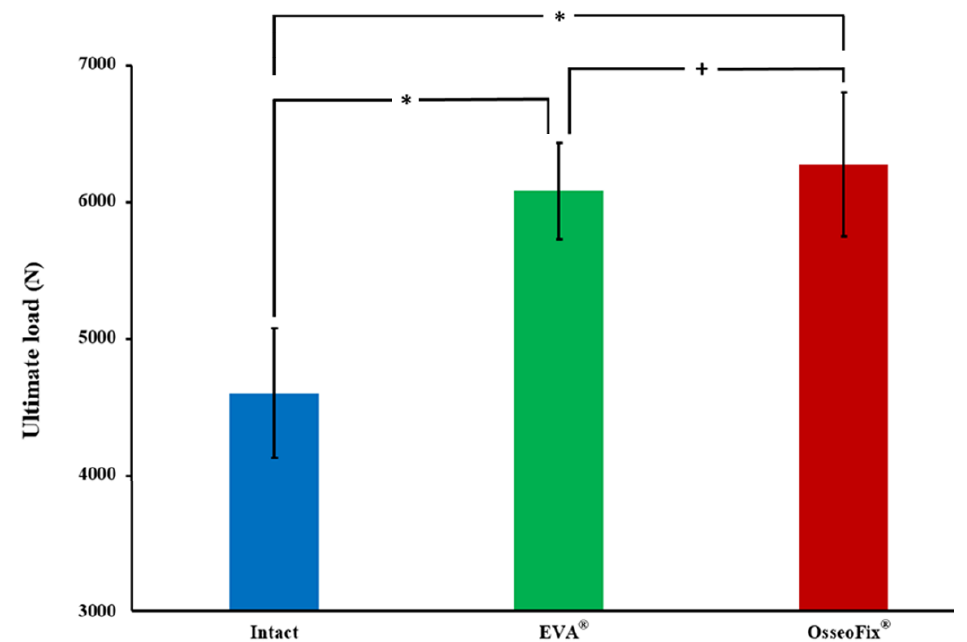
Figure 6. Mean anterior VBH ratio of preaugmentation and postaugmentation in the EVA® and OsseoFix® groups. Groups with significant differences ( p < 0.05) are indicated with the “*” symbol.